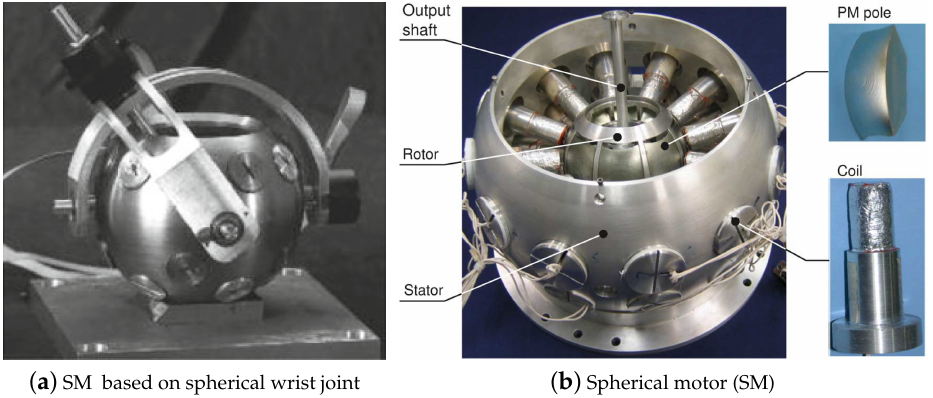
Figure 22. Two examples of spherical motors [111,112].